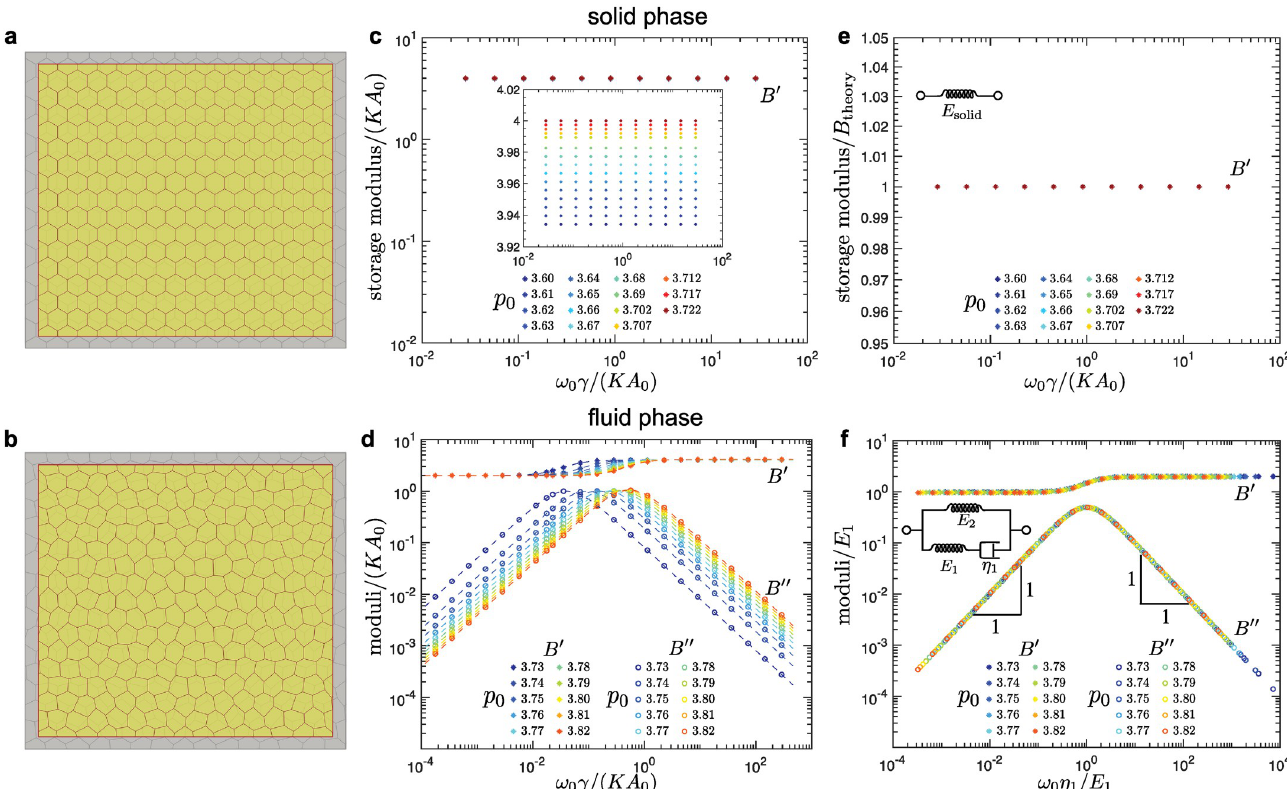
Fig 6. Loss and storage bulk moduli in the solid (top row) and fluid phase (bottom row) for hexagonal tilings. (a-b) An overlay of the representative reference (grey) and biaxially deformed (yellow) configurations in (a) the solid and (b) the fluid phase. The magnitude of the bulk deformation is highly exaggerated for demonstration purposes. (c-d) Representative storage ( B 0 ) and loss ( B 00 ) bulk moduli as functions of the deformation frequency, ω 0 , for different values of the cell- shape parameter, p 0 . For the solid phase in (c), the loss bulk modulus B 00 � 0. For the fluid phase in (d), dashed curves are the fits based on the Standard Linear Solid (SLS) model [see Eq (5)]. (e-f) The collapse of the moduli curves for different values of p 0 for (e) the solid phase and (f) the fluid phase. The insets show the representation of (e) the spring model and (f) the SLS model in terms of the springs and dashpots. In panel (e), B theory corresponds to the analytical prediction in Eq (9) for the storage bulk modulus in the solid phase.